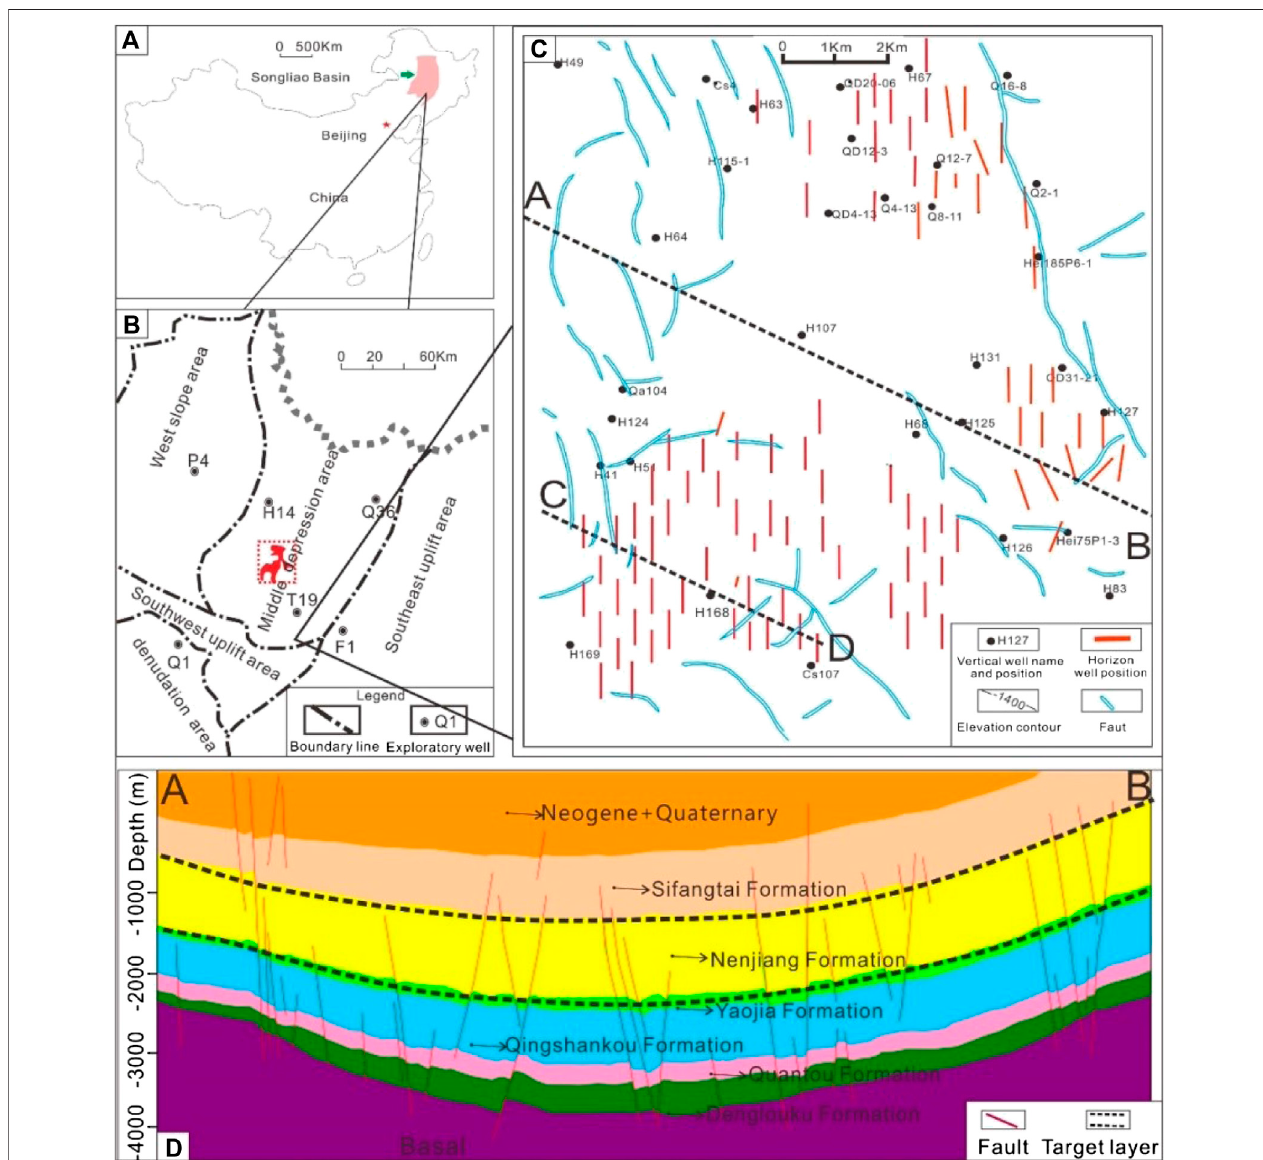
FIGURE 1 | Location map of the study area. (A) Location of Songlike Basin; (B) location of Changling Depression in southern Songlike basin; (C) location and well location map of the study area; (D) stratigraphic pro fi le of the study area.